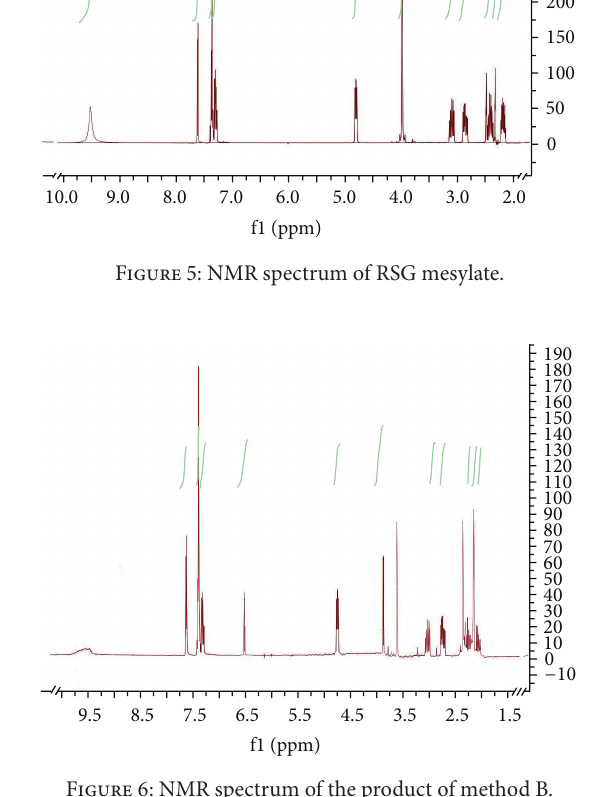
Figure 6: NMR spectrum of the product of method